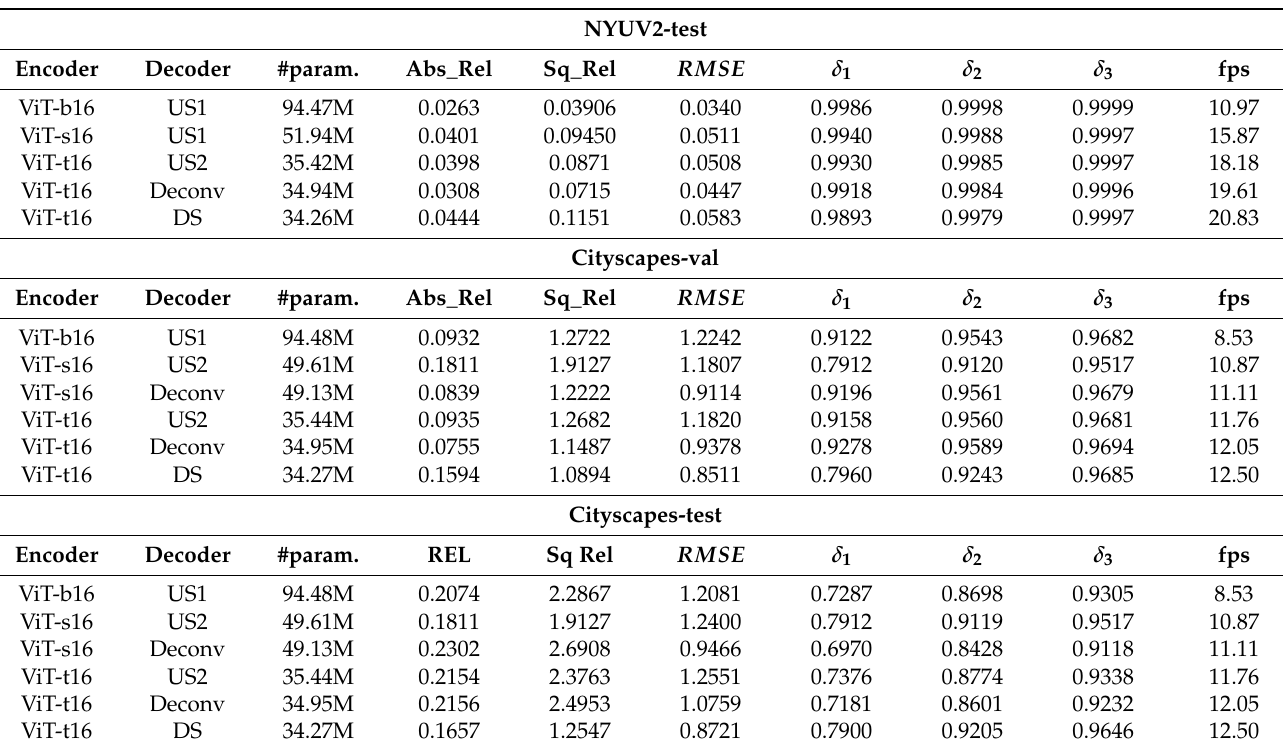
Table 1. Evaluation of the proposed architectures with different combinations of the encoder and decoder configuration on the NYU-depthV2 test-set and the CITYSCAPES validation-set and test-set. The evaluation metrics are those presented in Section 6 and we also report the number of parameters and the processing speed (frames per second) for each